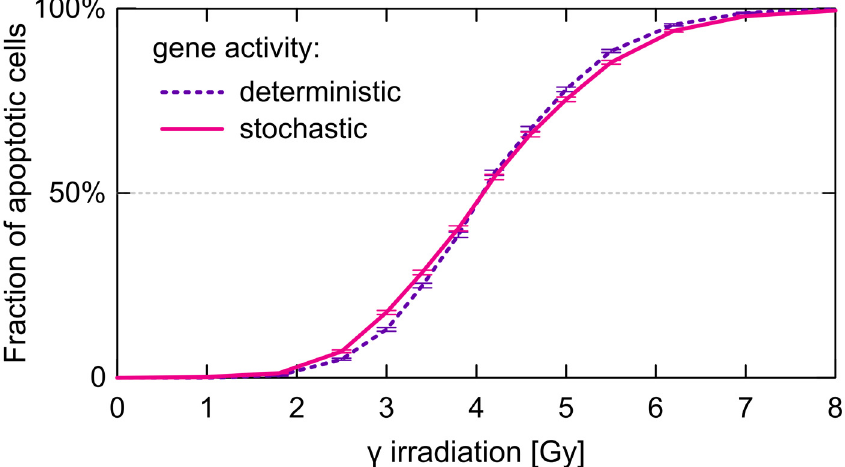
Fig 10. Fraction of apoptotic cells as a function of irradiation dose for two types of stochastic simulations. For each of analyzed doses the fraction and corresponding error was calculated based on 5000 stochastic single-cell simulations. The state of the cell was checked at 72. hour after irradiation which, as shown in Fig 11, is sufficient for unanimous cell fate decision.